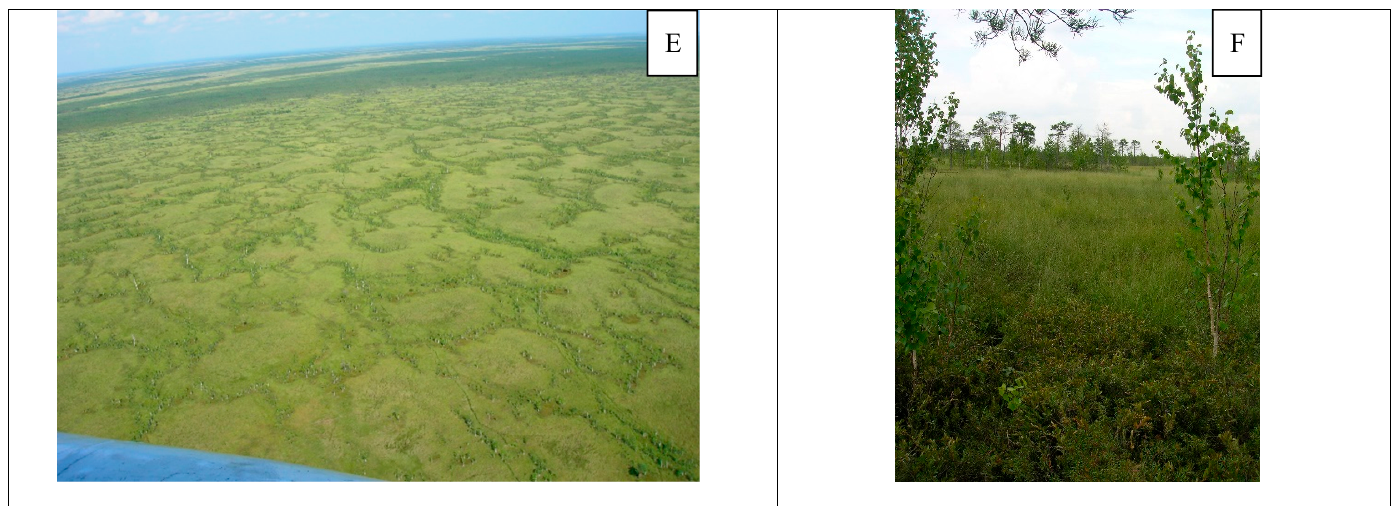
Figure 4. Examples of boreal and temperate wetland ecosystems ( left column ) and the associated foundation species ( right column ). ( A ) Ponded wetlands in Wood Buffalo National Park (Canada) (photo by Stephen Davis III). ( B ) Scanning electron micrograph of Cymbella pusilla (now called Navicymbula pusilla , photo by Marina Potapova from a sample from Wolf Creek, Missouri, USA; scale bar: 5 µm [135]). ( C ) Boreal wetland in the Northwest Territories, Canada (Boreal Songbird Initiative; photo by Chad Delany). ( D ) Sphagnum mosses are widely distributed in boreal wetlands and elsewhere (photo taken by Todd Crowl in Upper Michigan). ( E ) Aerial photograph of a patterned peatland (the Great Vasyugan Bog, Siberia, Russia; photo by Maarten Eppinga), where tree species such as Betula pubescens and Pinus sylvestris dominate elevated patches. ( F ) Close-up view of an elevated ridge with B. pubescens with P. sylvestris in the background (photo by Maarten Eppinga).